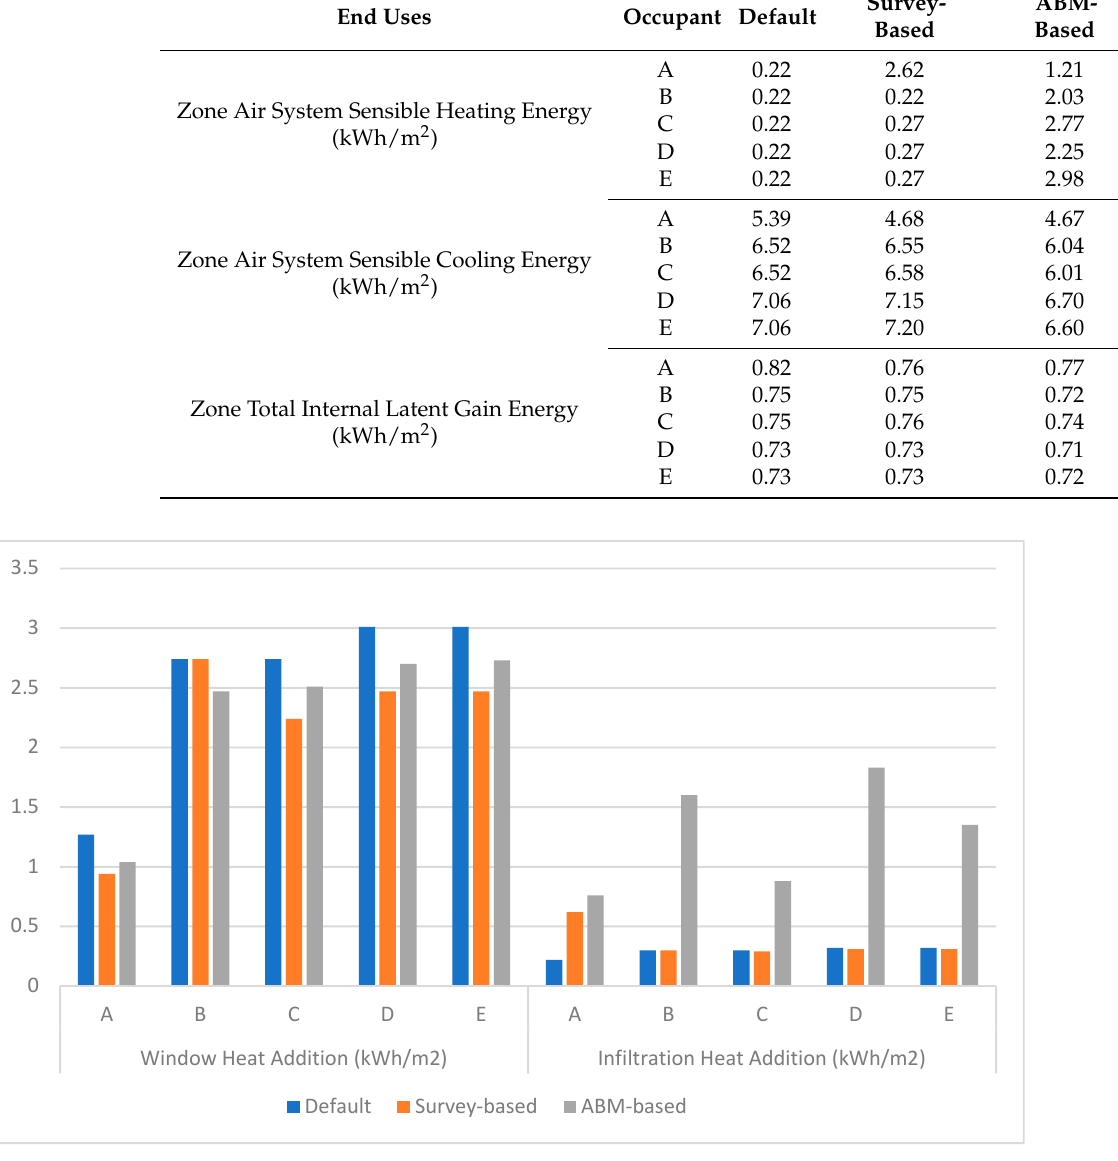
Figure 8. Building sensible heat gain factors.